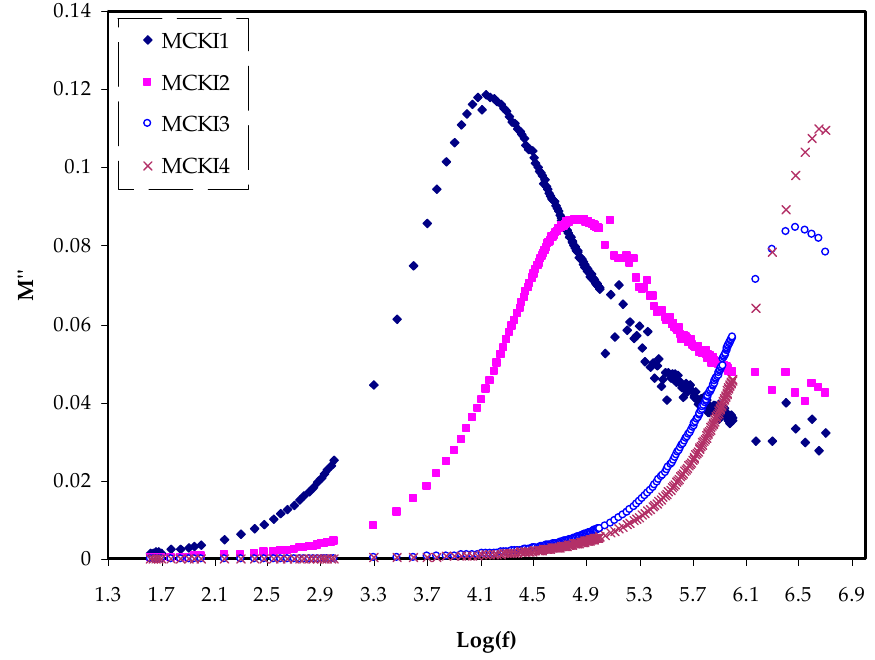
Figure 7. Electric modulus plot of M i against log(f) for the MCKI samples.